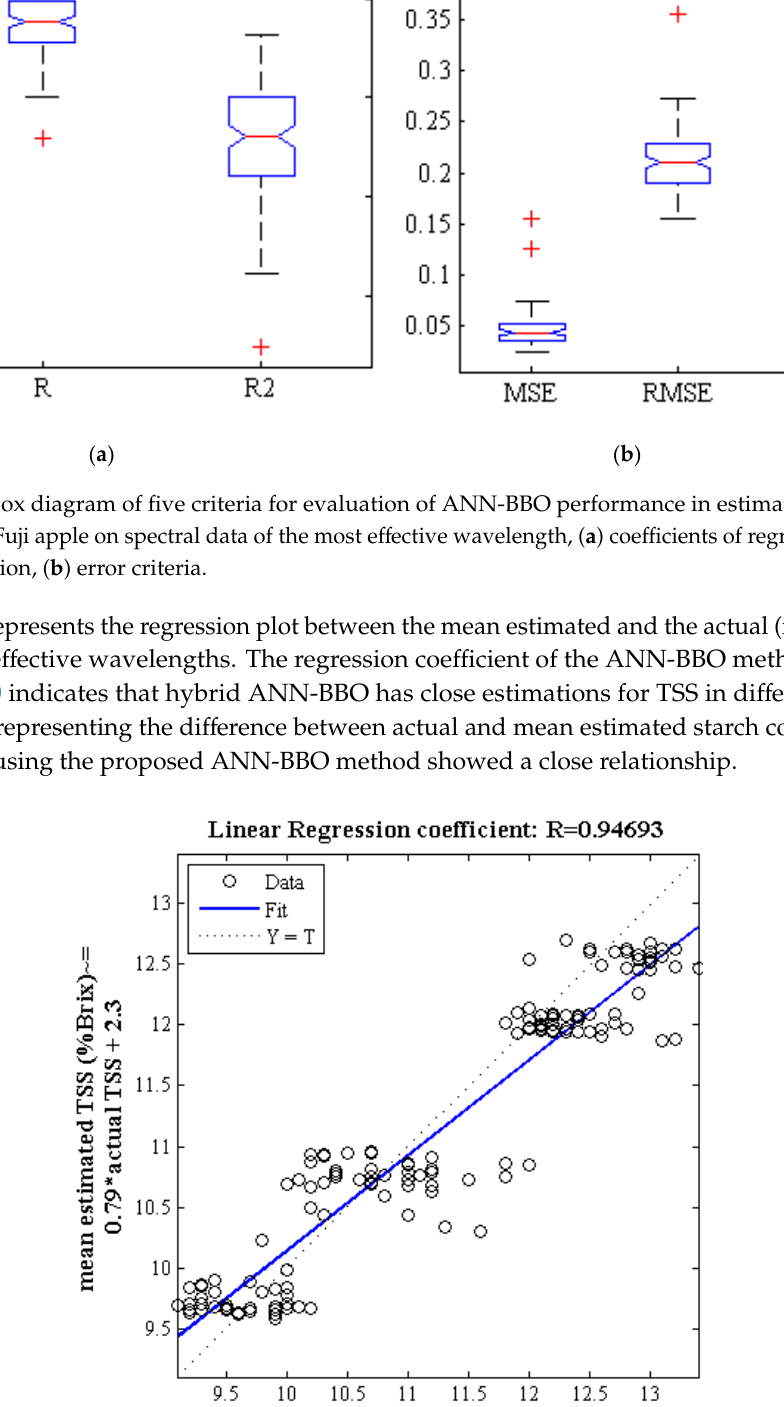
Figure 7. Regression analysis of the scatter plot between the mean estimated and the measured starch content in Fuji apple based on the most effective wavelength’s spectral data.